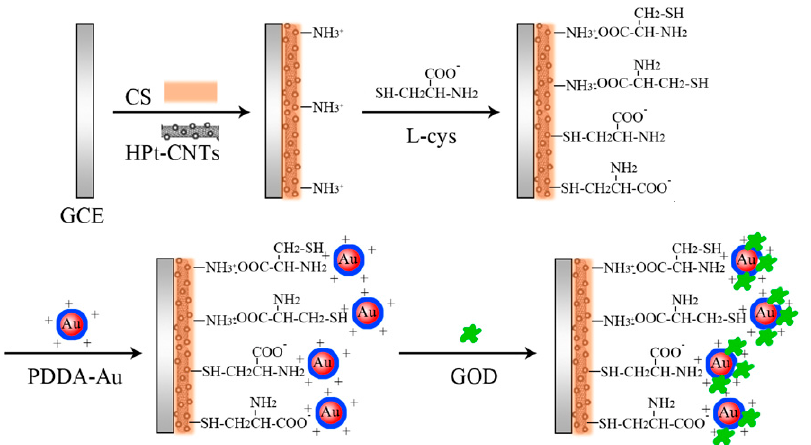
Figure 4. Schematic of the fabrication process of the biosensor on which the multiwall CNTs (HPt- CNTs) has been decorated with unique hollow nanostructured Pt [37]. Copyright 2011.